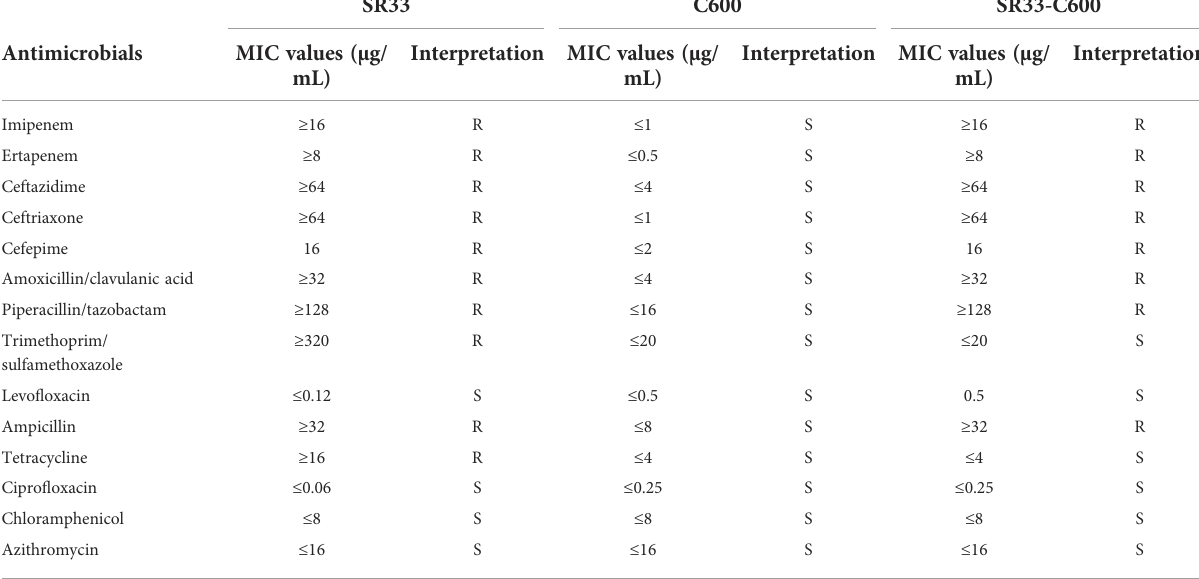
TABLE 1 MIC values of antimicrobials for SR33 and its